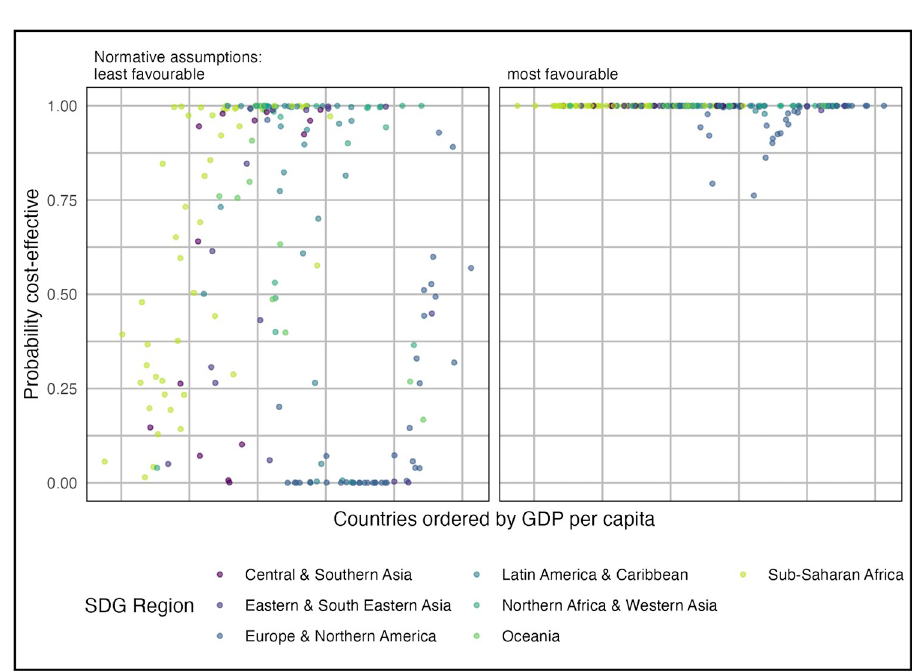
Fig 3. Probability that GBS maternal vaccination is cost-effective in each country under most favourable and least favourable normative assumptions (see Table 1). Least favourable normative assumptions were the use of an empirical CET, 3% discounting of QALYs, and exclusion of stillbirth QALYs. Most favourable assumptions were the use of 1 × GDP per capita CETs, 0% discounting of QALYs, and inclusion of stillbirth QALYs. CET, cost-effectiveness threshold; GBS, Group B Streptococcus; GDP, Gross Domestic Product; GDPPC, GDP per capita; QALY, quality- adjusted life year; SB, stillbirth; SDG, Sustainable Development